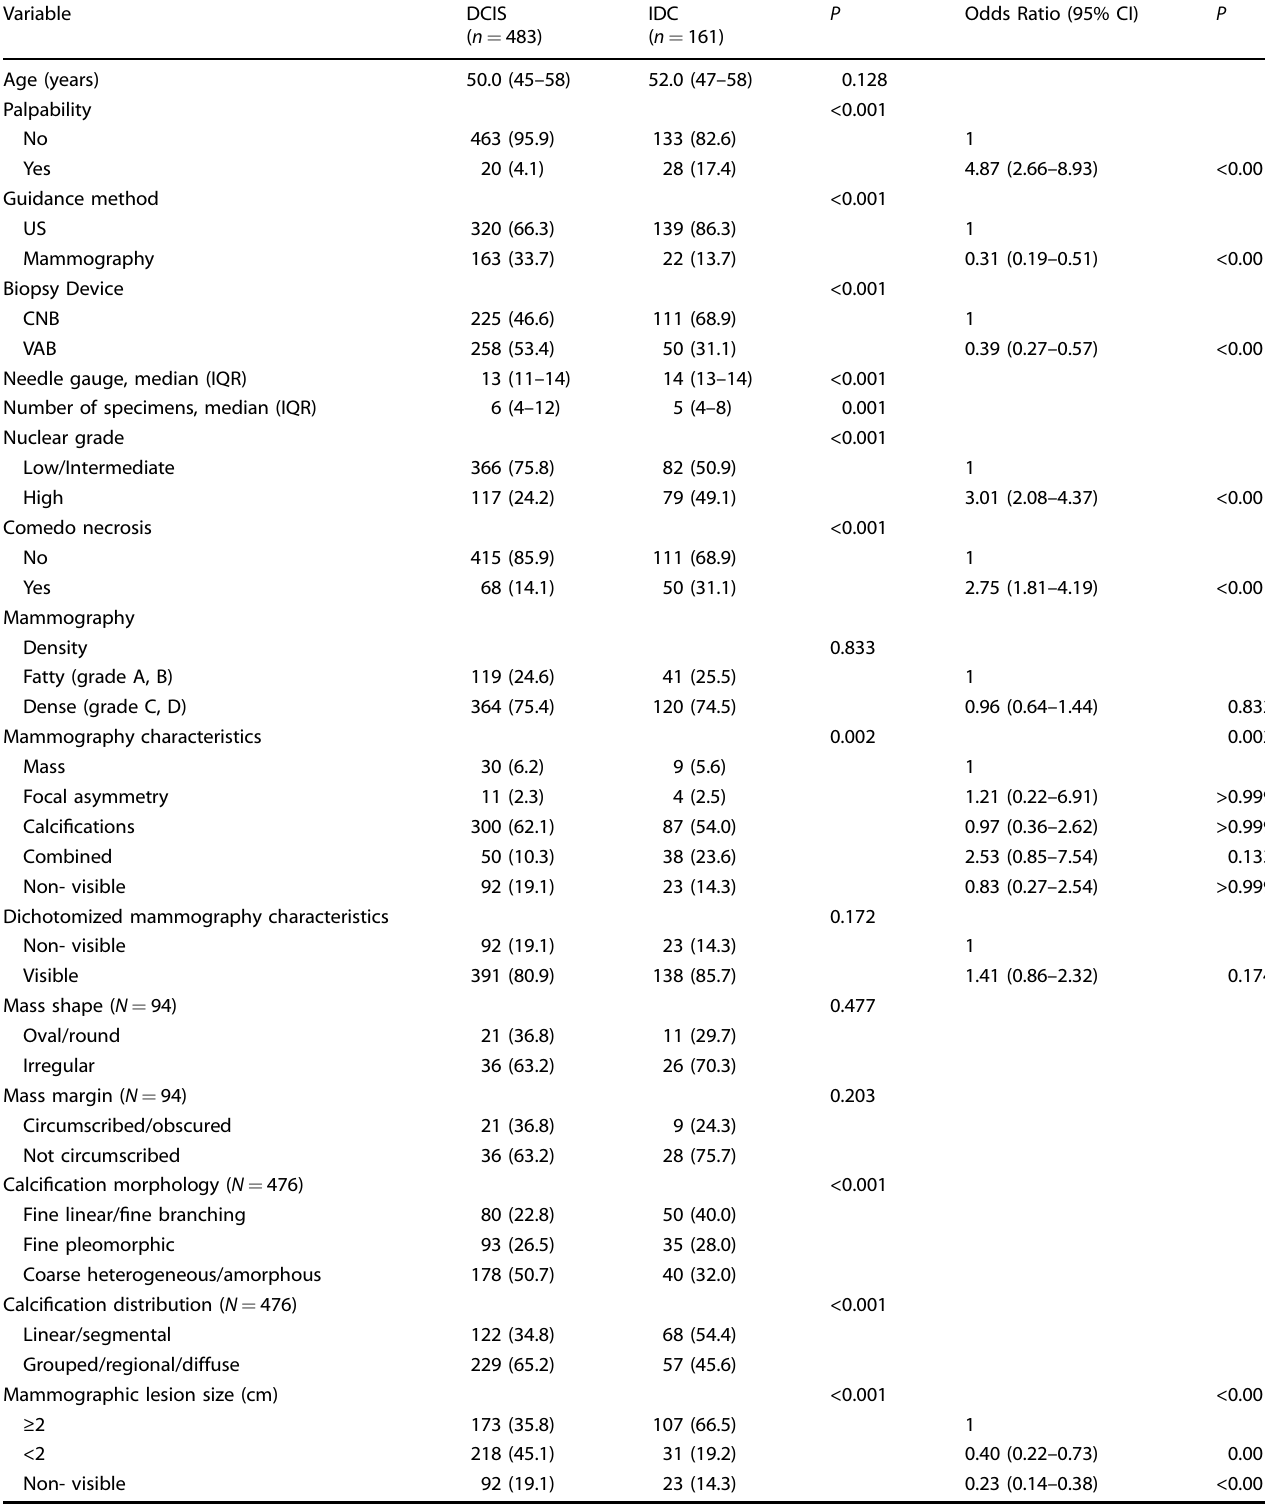
Table 1. Patient characteristics and univariable analysis of factors associated with the underestimation of invasive carcinoma (clinicopathologic and mammographic fi